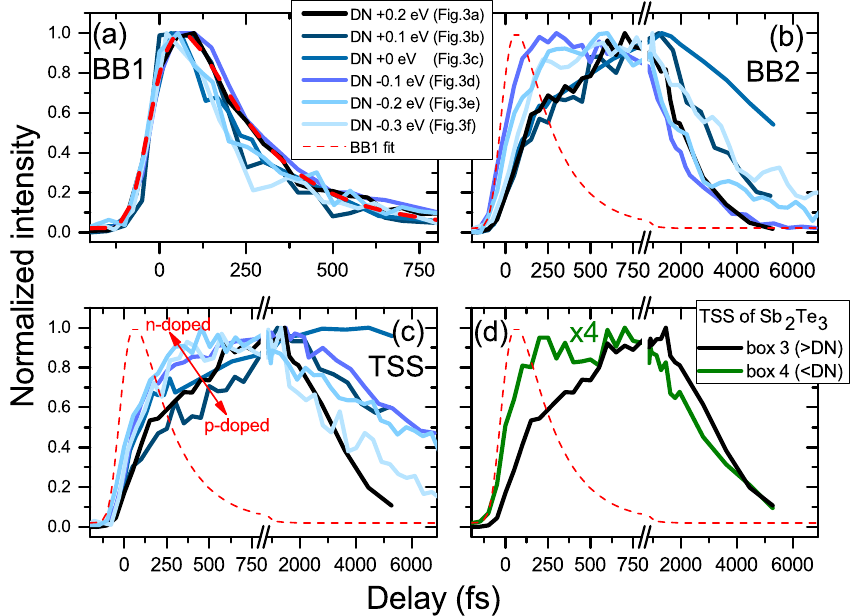
Figure 4. Summary of the electronic dynamics for different bands and doping levels (same color code as Figure 3) of the BSTS samples. The curves are normalized to their respective maxima. ( a ) BB1 band dynamics (box 1 in Figure 3). The red dashed line is a phenomenological fit and it has been reproduced in all panels for comparison. ( b ) BB2 band dynamics (box 2 in Figure 3). ( c ) TSS band dynamics (box 3 in Figure 3). The intensity build-up is faster for p-doped samples (as evidenced by the red arrow). Notice the extremely long electron lifetime for the undoped samples (DN at the Fermi level). ( d ) Comparative dynamics of the upper and lower branches of the TSS in Sb 2 Te 3 (boxes 3 and 4 of Figure